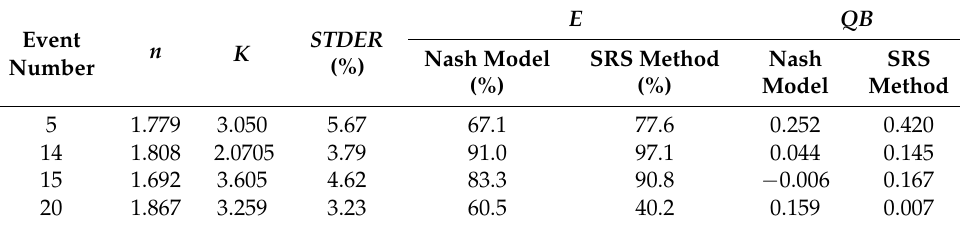
Table 2. Nash IUH parameters, STDER , and QB for the selected storm events of Nenagh basin.